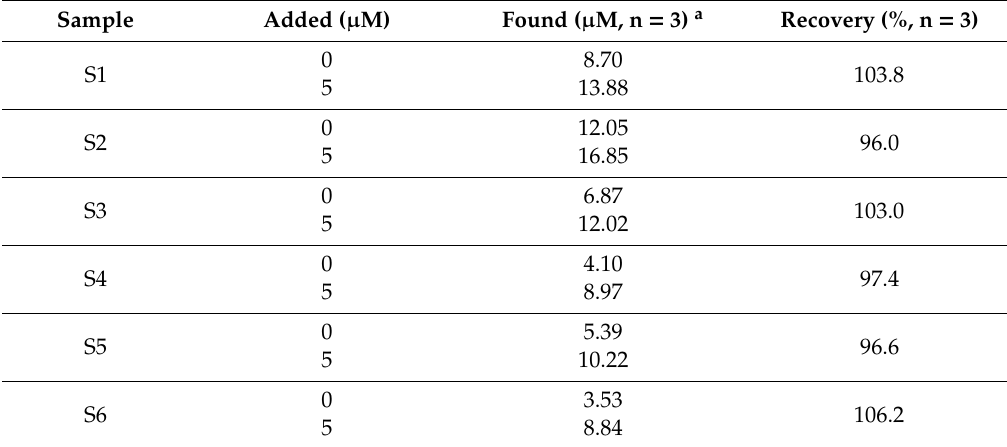
Table 2. Detection of ca ff eine in actual samples (n =